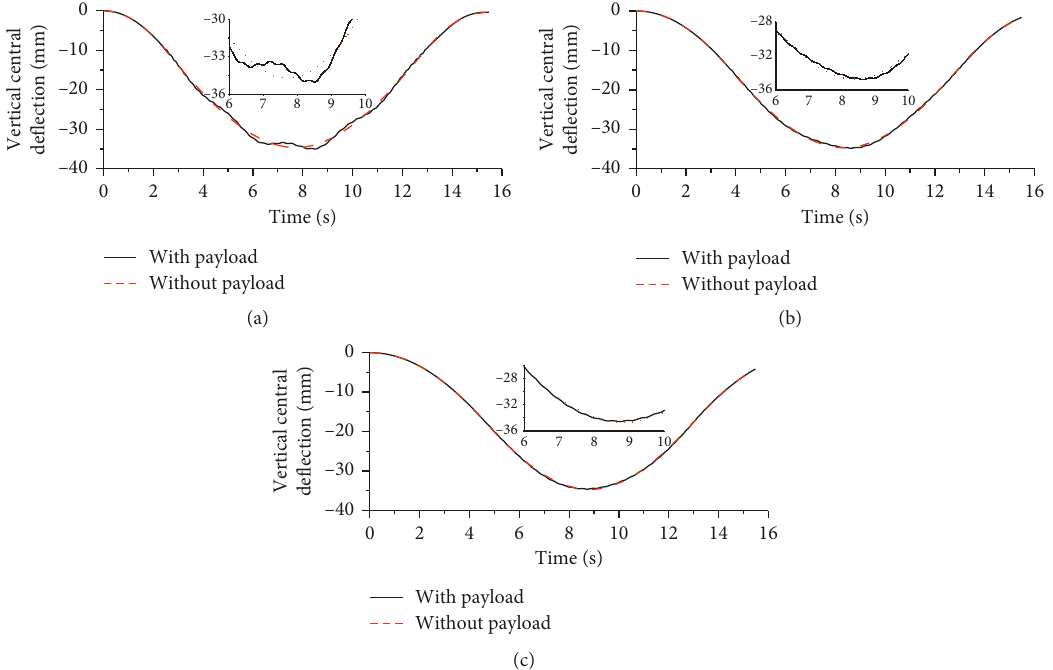
Figure 7: The deflection of a beam affected by payload swing: (a) when the cable length is 6m; (b) when the cable length is 14m; (c) when the cable length is